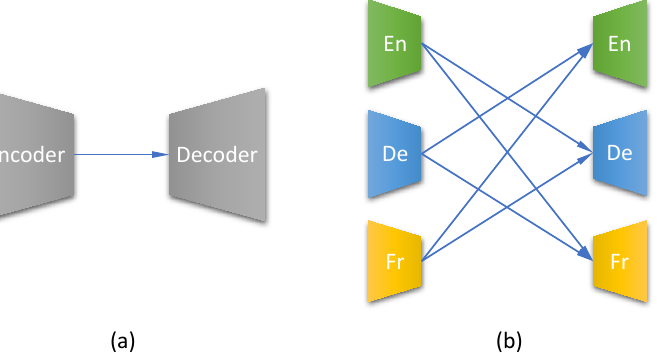
Figure 1. Overview of two common forms of multilingual NMT models for three languages: English (En), German (De), and French (Fr). ( a ) The 1-1 model, which shares all model parameters for all six directions. ( b ) The M2 model, in which only language-specific modules are shared.